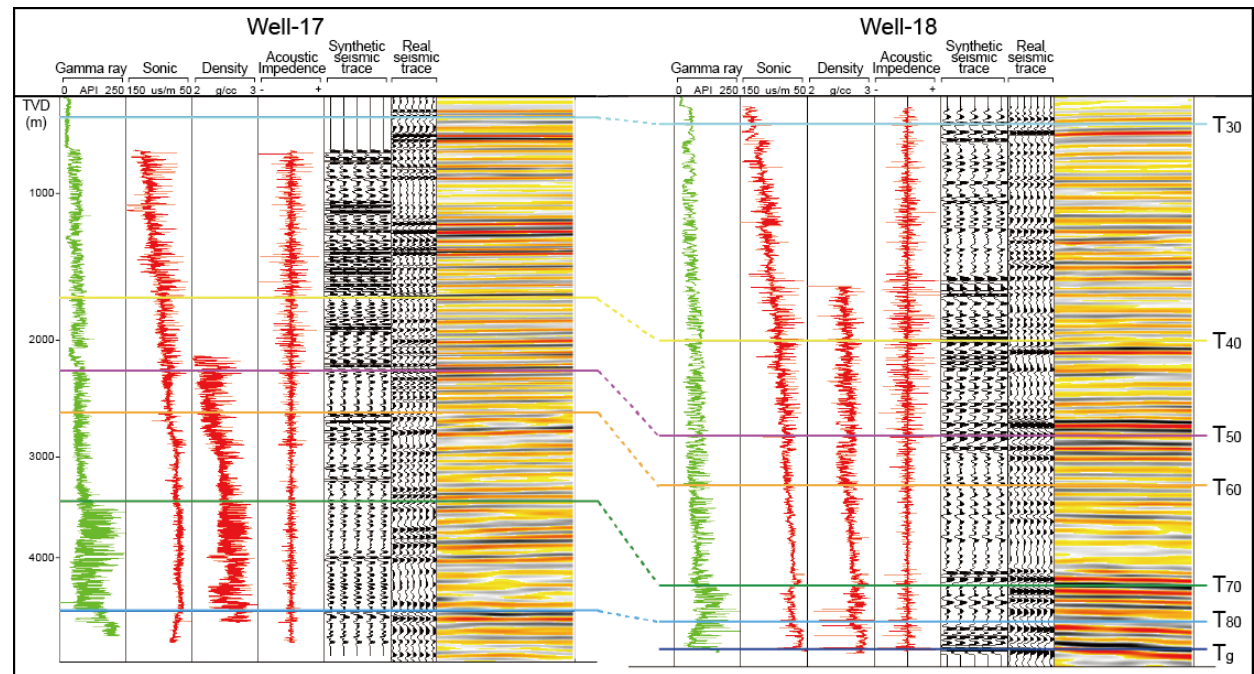
Figure 3. Seismic-well ties for Well-17 and Well-18. See Fig. 1c for the location of the wells. Seismic data are displayed in normal polarity (SEG Convention), whereby a peak (brown reflection) represents an increase in acoustic impedance and a trough (black reflection) represents a decrease in acoustic impedance. T 30 to T 60 are correlated seismic horizons in the Pearl River Basin, and T 70 to T g are the key seismic horizons interpreted in the study